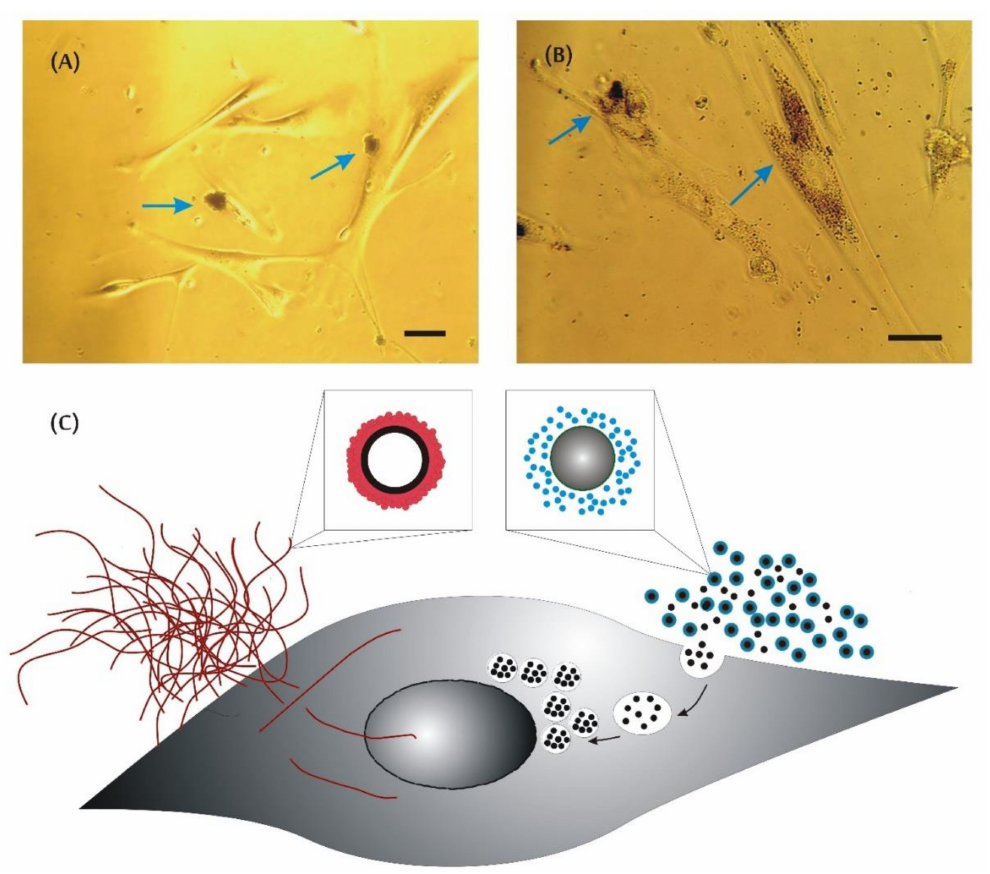
Figure 7. Mesenchymal stem cells after 30 days of culture in presence of ( A ) SWCNT and ( B ) ACNM. Bars indicate 10 µ m; arrows show CNM agglomerates ( A ) outside or ( B ) inside cells. ( C ) Proposed mechanism of carbonaceous-material interaction with proteins and mesenchymal stem